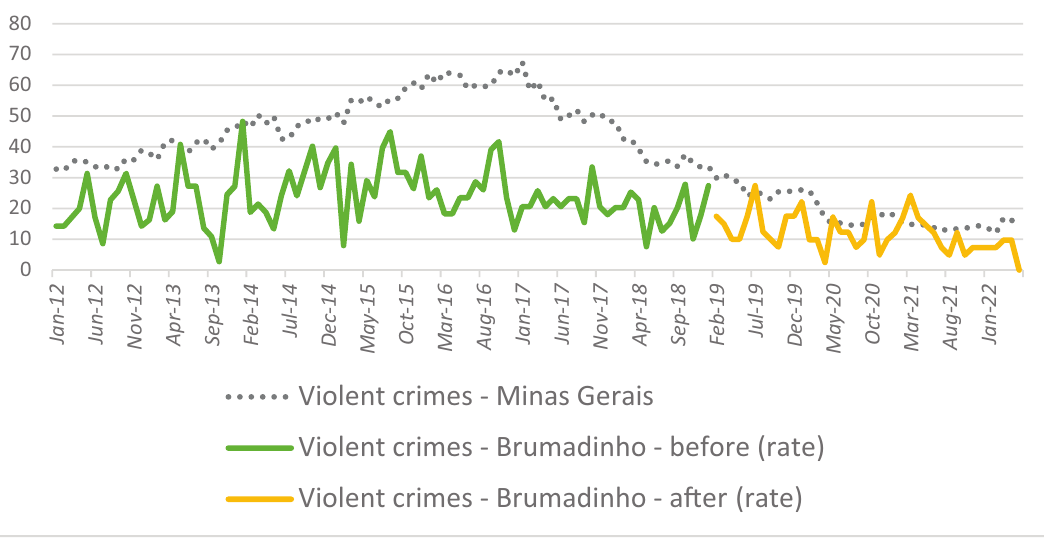
Figure 11. Rate of violent crimes per month, for Minas Gerais and Brumadinho – 2012- 2022 Source: Occurrences: Armazém Sisp (official data warehouse for Minas Gerais state public security system). Demographic data: